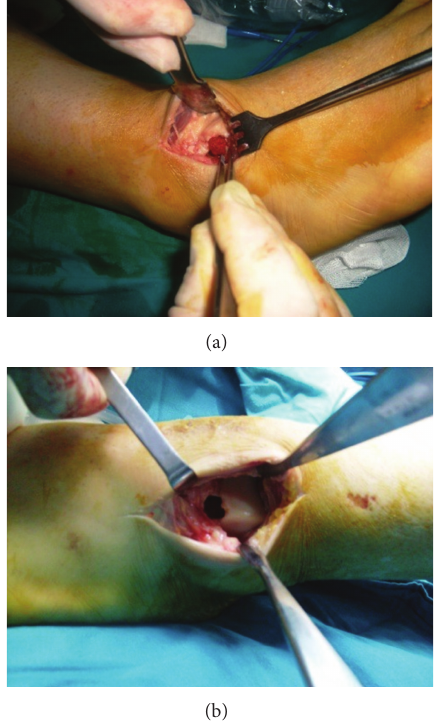
Figure 3: (a) After the procedure containing curettage and autolo- gous grafting have been done to both talus. (b) As the first step of the procedure curettage has been done to both